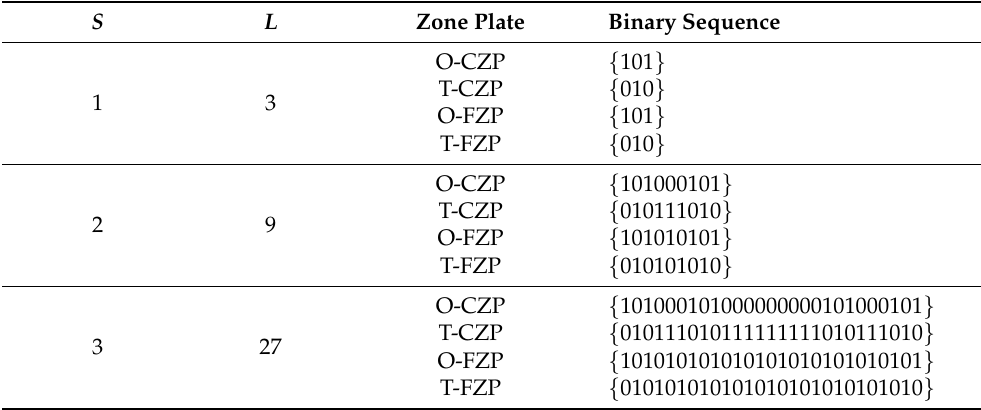
Table 1. Binary sequences for different CZPs and their associated FZPs.